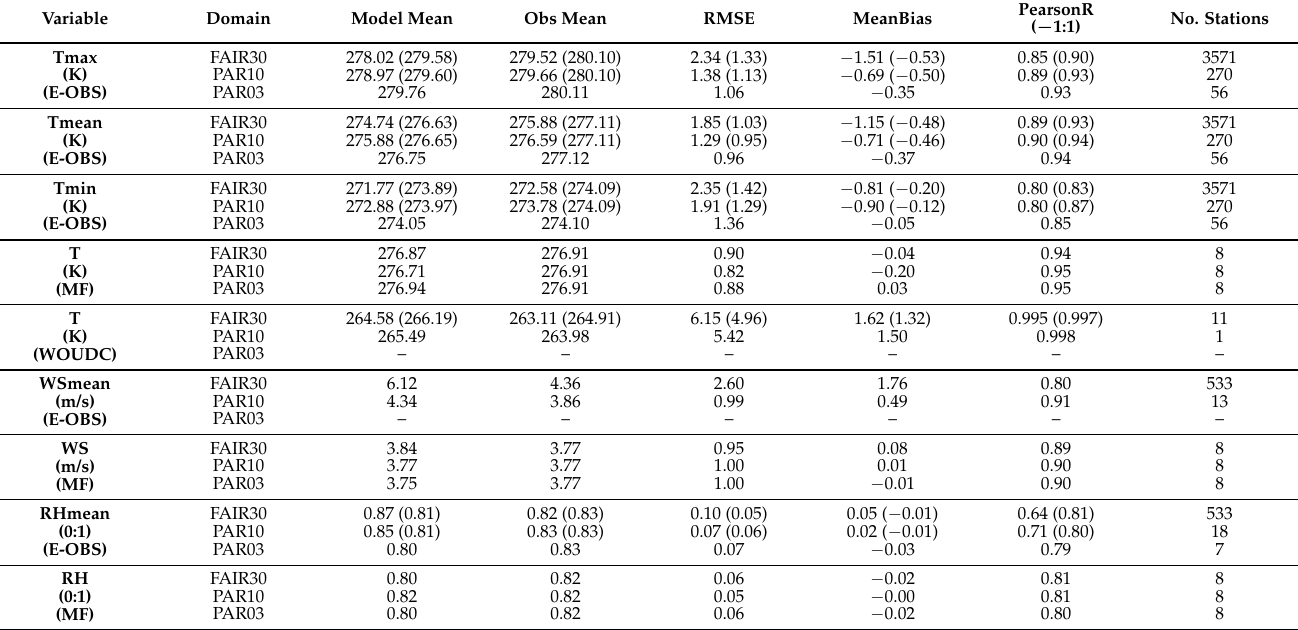
Table 2. Error statistic for meteorological parameters shown in Figure 3. Units are given on the left side of each section. Comparisons are separated by type of station, and types of stations are also given on the left side of each section. All the stations are shown in (Figure 2). The values given in the brackets for FAIR30 and PAR10 show the error statistics for common stations between all domains.